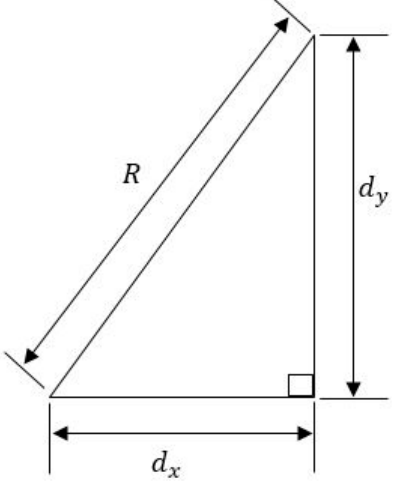
Figure 3. Displacements on ground using the resultant method.